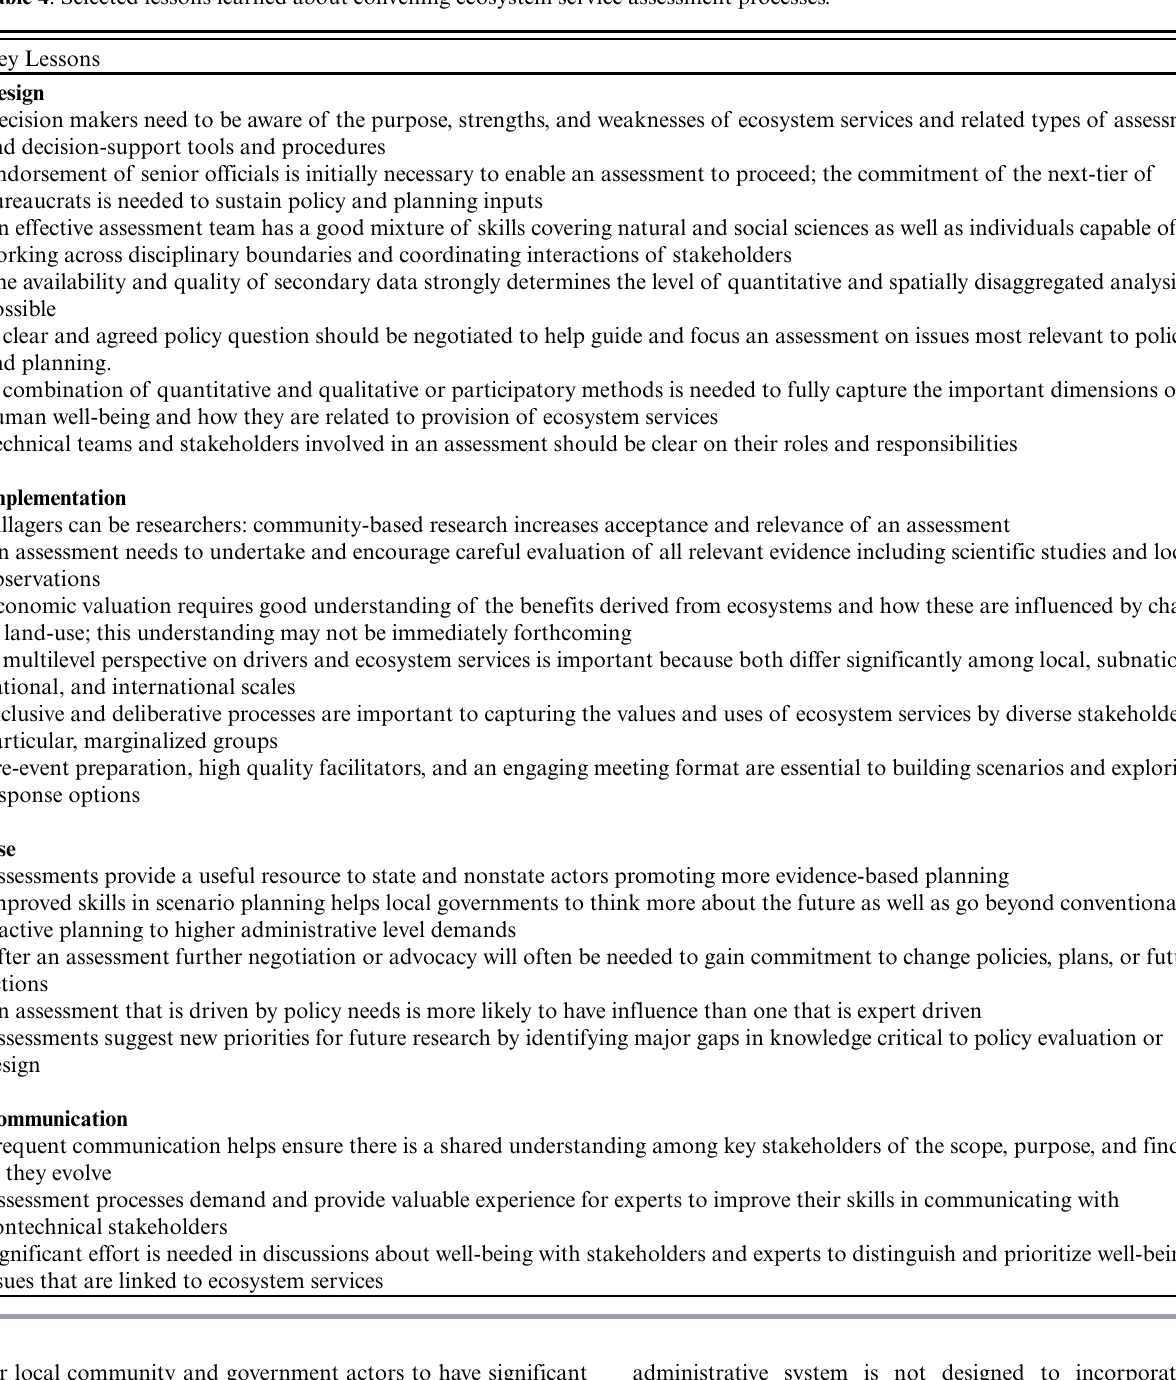
Table 4 . Selected lessons learned about convening ecosystem service assessment